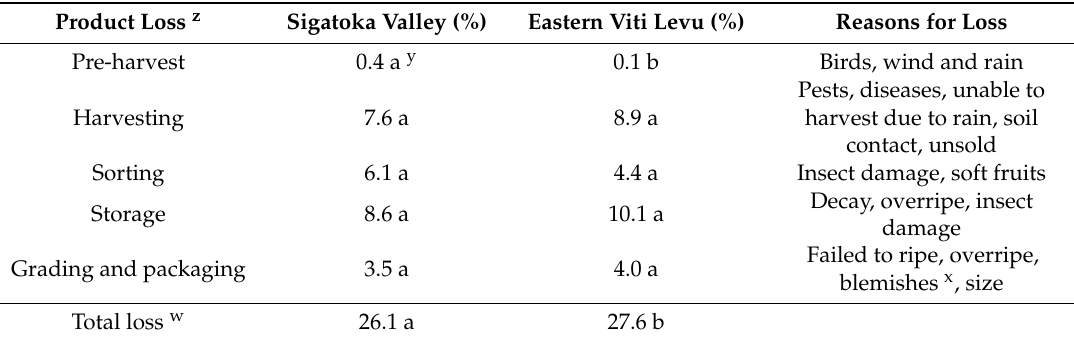
Table 4. Mean percent product loss as a consequence of pre-harvest and postharvest